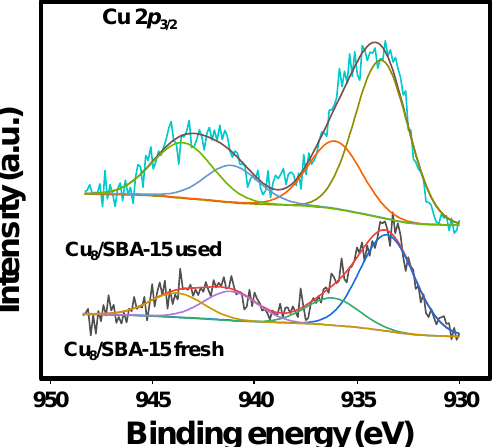
Figure 4. Cu 2 p 3/2 core level spectra for Cu 8 /SBA-15 fresh and used samples.